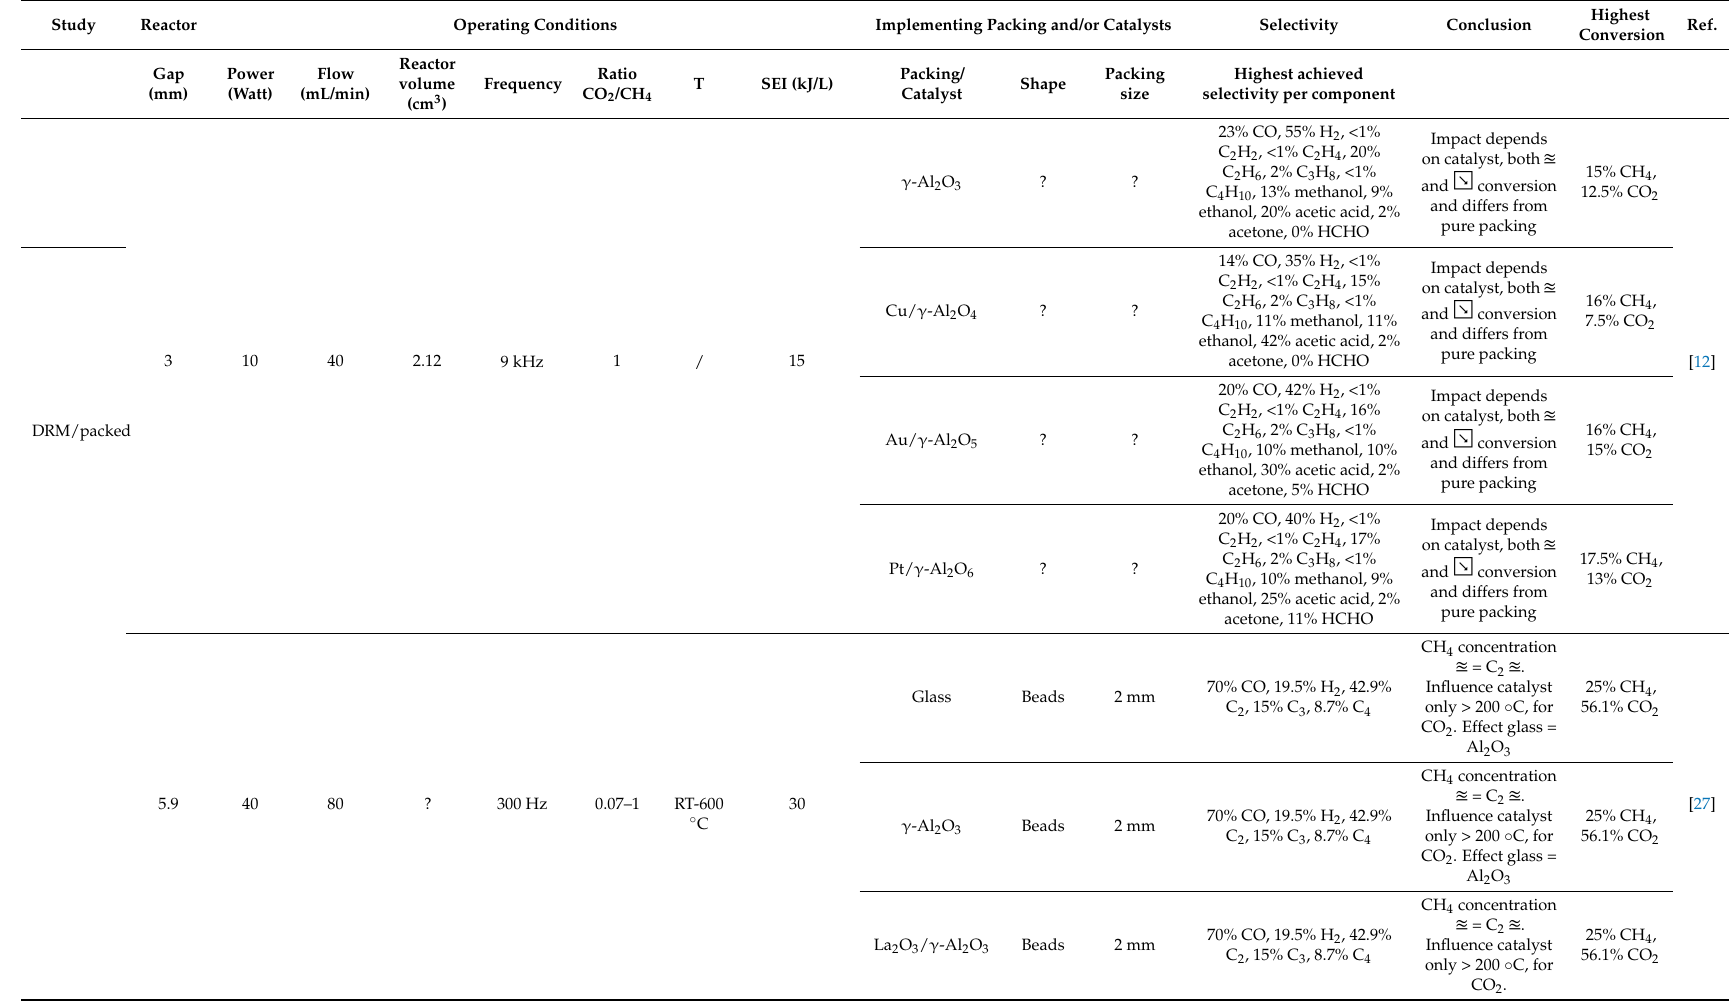
Table 1. Summary of a selection of literature for CO 2 splitting in a non-packed and a packed DBD reactor.